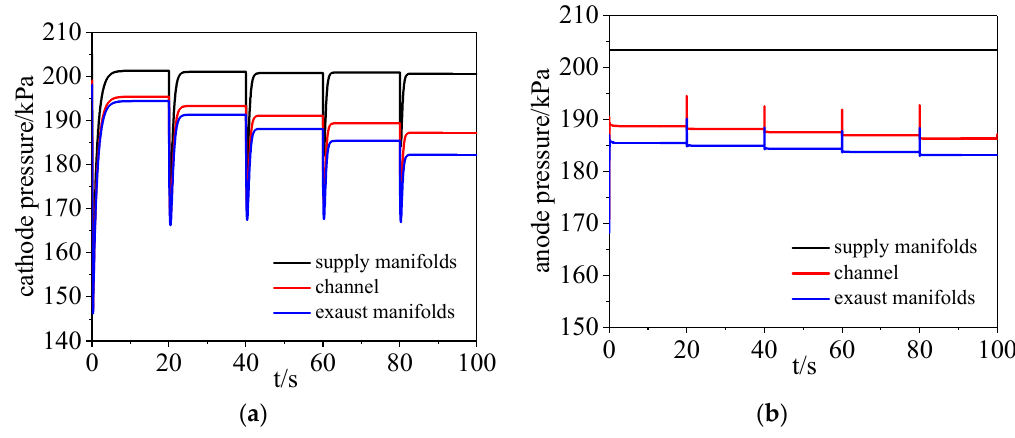
Figure 3. Pressure dynamics in the channel, according to calculations: ( a ) cathode, ( b ) anode.